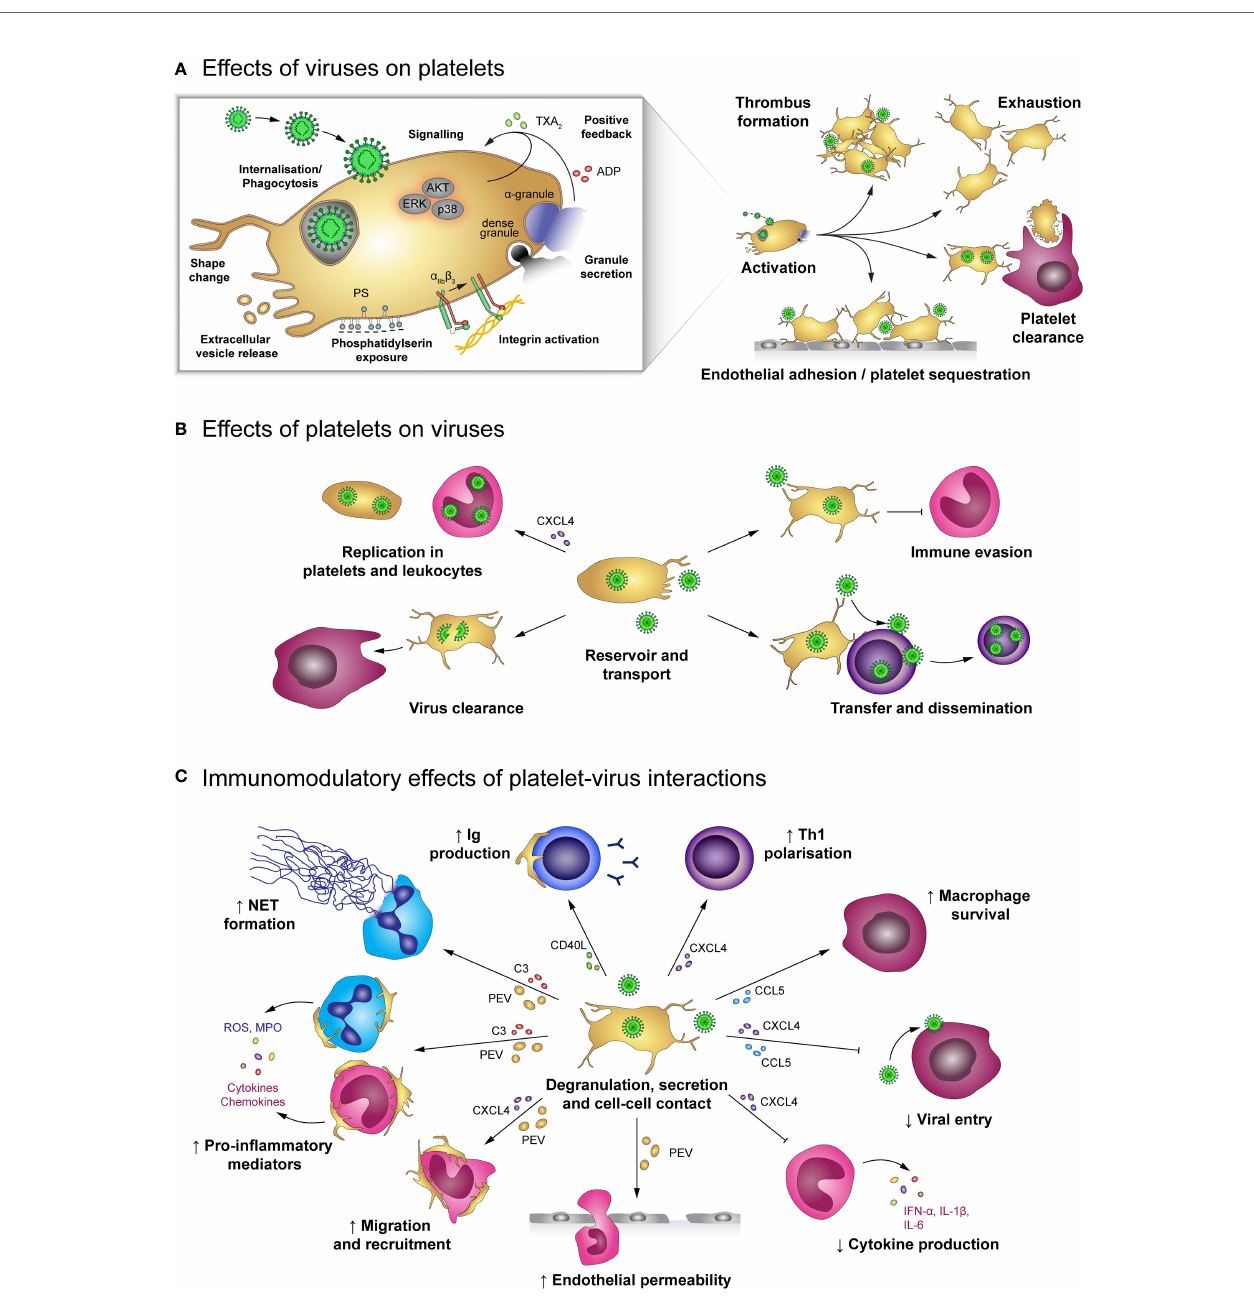
FIGURE 3 | Effects of platelet-virus interaction. (A) Virusbinding or internalisation/phagocytosisstimulates platelet activation includingdegranulation, integrin activation, phosphatidylserin exposure andextracellular vesiclerelease. Virus-induced platelet activation enhances endothelial adhesion and thrombus formation,but may also lead to platelet exhaustion and clearance fromthe circulation. (B) Platelets serve as virusreservoir andtransport vehiclebysupporting viral replication inleukocytes or within platelets themselves andby transferringvirus to other host cells, thereby augmentingviraldissemination.Furthermore, platelets shelter intracellular virions fromimmune-mediated degradation,though degradation of virus-containing platelets contributes to virusclearance. (C) Virus-stimulated platelets modulate immuneresponses bycell-cell contact and/or soluble mediators. Platelet-derived factorsblockviral entry into leukocytes and prolongmacrophage survival. Platelets also facilitate leukocyte extravasation by augmenting endothelial permeability,leukocyte migration andrecruitment. Furthermore, platelets regulate leukocyte effector functions such as IgG production, T cell polarization,NET formation andrelease ofin fl ammatory mediators, thereby either enhancing ordiminishing immune defences. ADP, adenosine diphosphate; AKT, Protein kinase B;C3, complement factor3; CCL5, chemokine (C-C motif) ligand 5; CD40L, CD40 ligand; CXCL4, chemokine (C-X-C motif) ligand 4; ERK, Extracellular signal- regulated kinase; IFN- a : Interferon a ; IgG, immunoglobulin;IL-1 b : Interleukin 1 b ; MPO, myeloperoxidase; NET, neutrophilextracellular trap;p38, p38 mitogen-activated protein kinase; PEV, Platelet-derivedextracellular vesicle; PS, phosphatidylserine; ROS, reactiveoxygen species; Th1, T helper celltype1; TXA 2 , thromboxane A 2